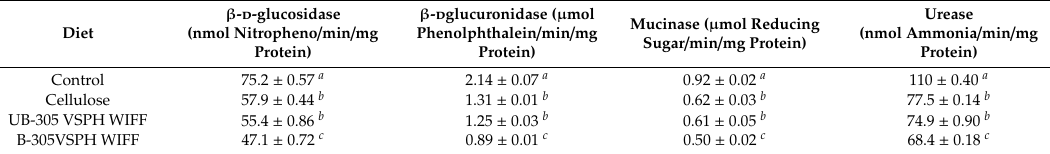
Table 6. Fecal enzyme activities of the hamsters fed diets with cellulose or WIFF of UB-305VSPH and